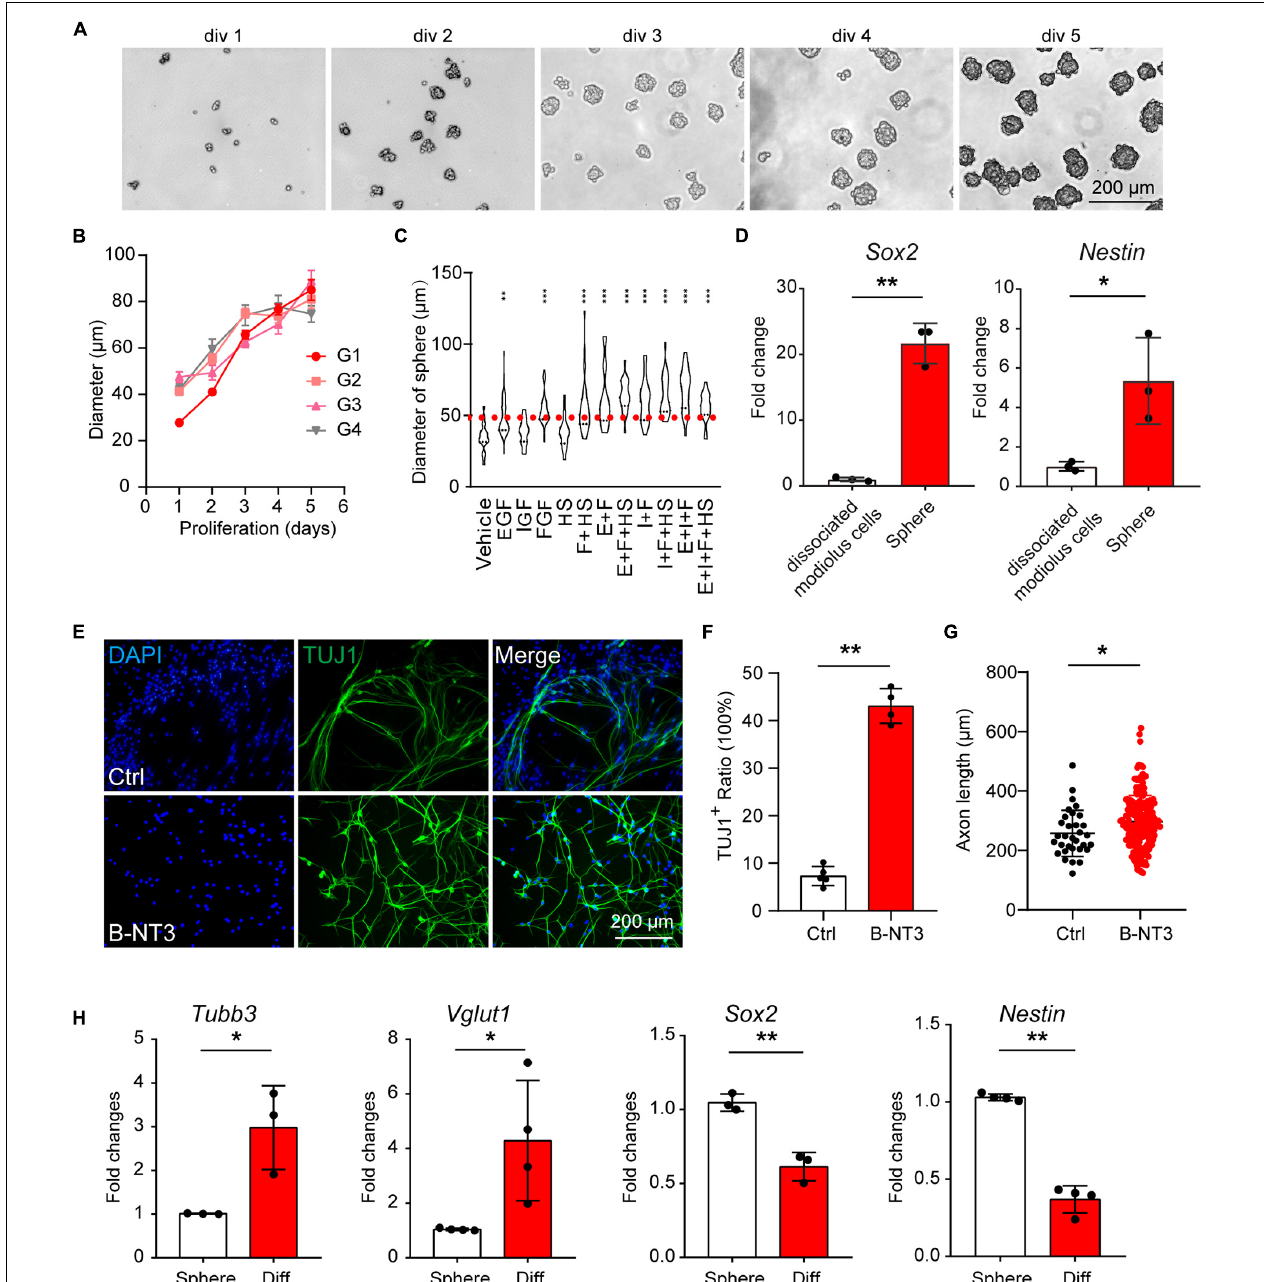
FIGURE 1 | Postnatal cochlear glial cells proliferate as neurospheres and differentiate into neuron-like cells. (A) Bright-field images of the proliferating generation 1 (G1) spheres at 1–5 days in vitro (div). (B) Diameters of G1–G4 spheres during propagation. (C) Quantification of sphere diameters at 5 div with supplementations of E, I, F, H. E, EGF; I, IGF; F, FGF, and H, heparan sulfate. N = 21–48. P -values were calculated against vehicle control. (D) mRNA expression of Sox2 and Nestin in cochlear spheres compared to controls (dissociate modiolus cells). N = 3, error bars represent mean ± SD. (E) Representative TUJ1-positive cells after differentiation at 18 div with BDNF and NT3 (B-NT3). (F) The ratio of TUJ1 positive cells. N = 5 and 4, error bars represent mean ± SD. (G) Axon lengths of the induced neuron-like cells. N = 35 and 220, error bars represent mean ± SD. (H) mRNA expression of Tubb3 , Vglut1 , Sox2 , and Nestin of either spheres or differentiated neuron-like cells (Diff). N = 3 or 4, error bars represent mean ± SD. * p < 0.05, ** p < 0.01, *** p < 0.001 by one-way ANOVA (C) or unpaired student’s t -test (D,F–H) .